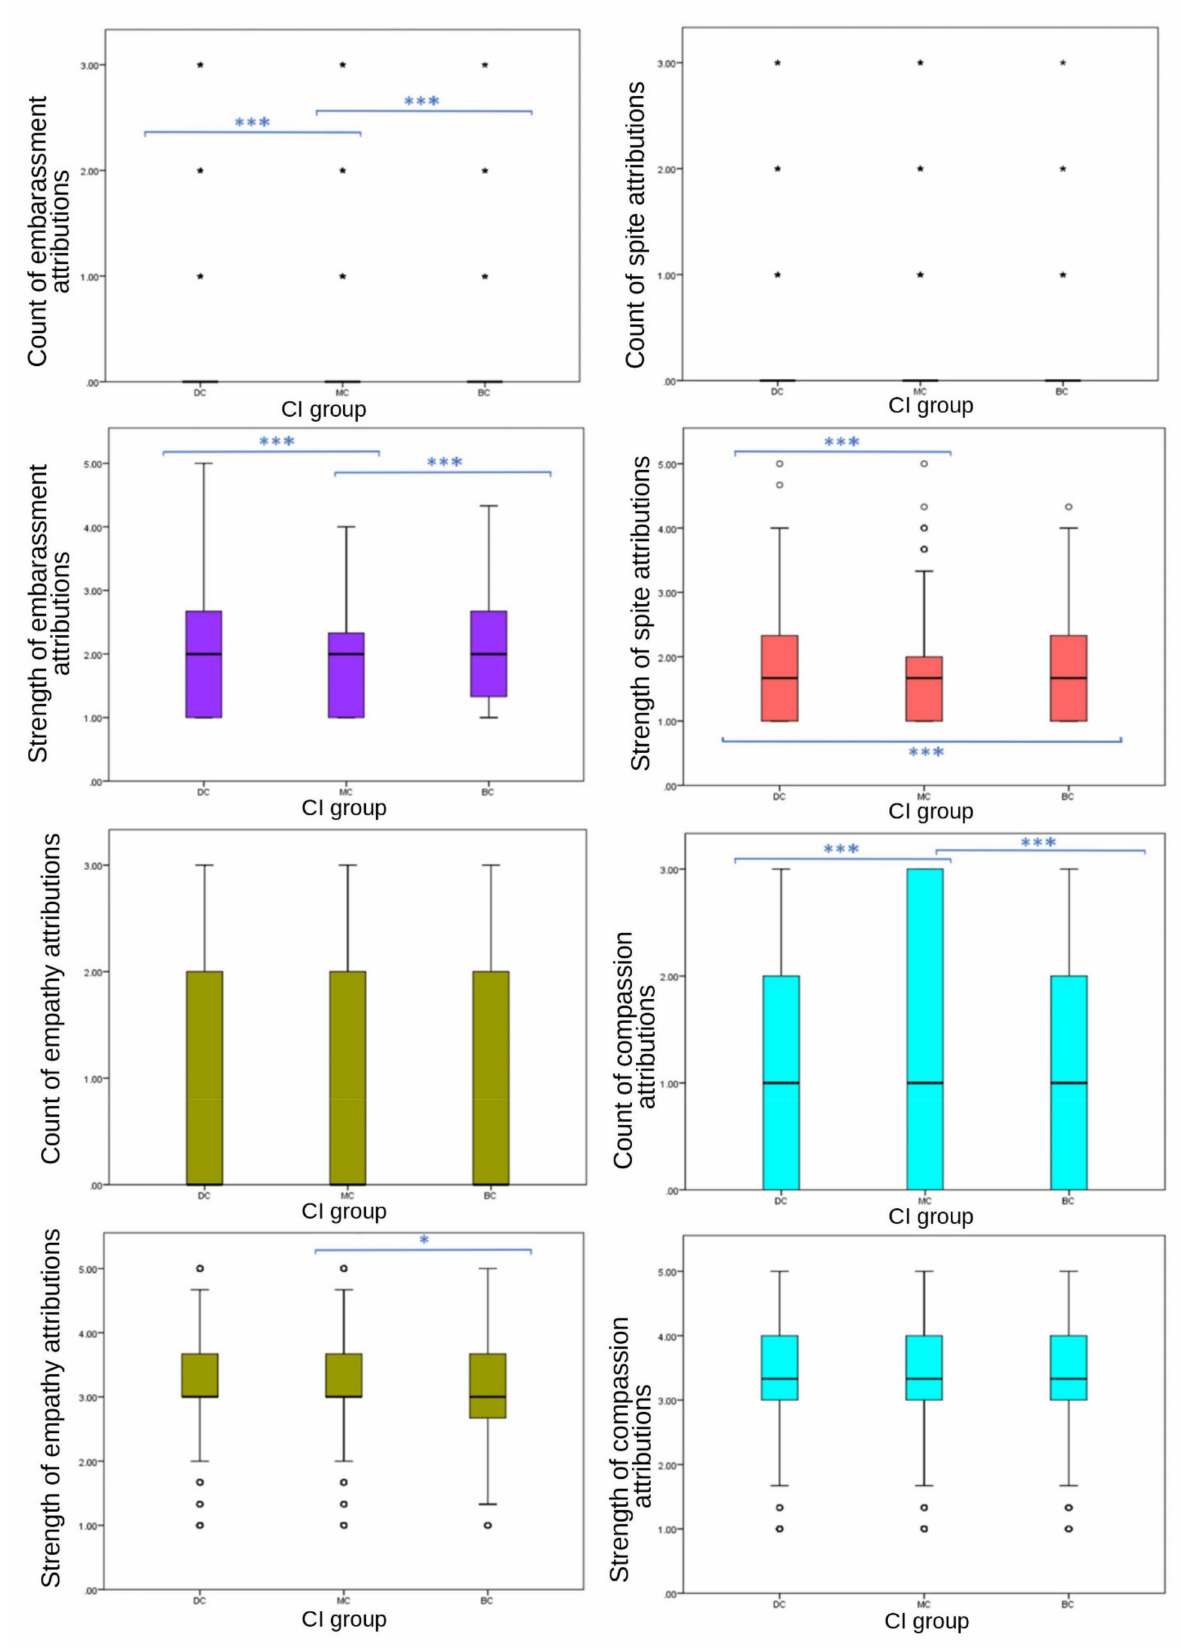
Figure 3. Box plots describing mean scores of individual secondary emotion frequencies and strengths between CI groups of dog images. (*** demotes statistically significant differences. ◦ denotes